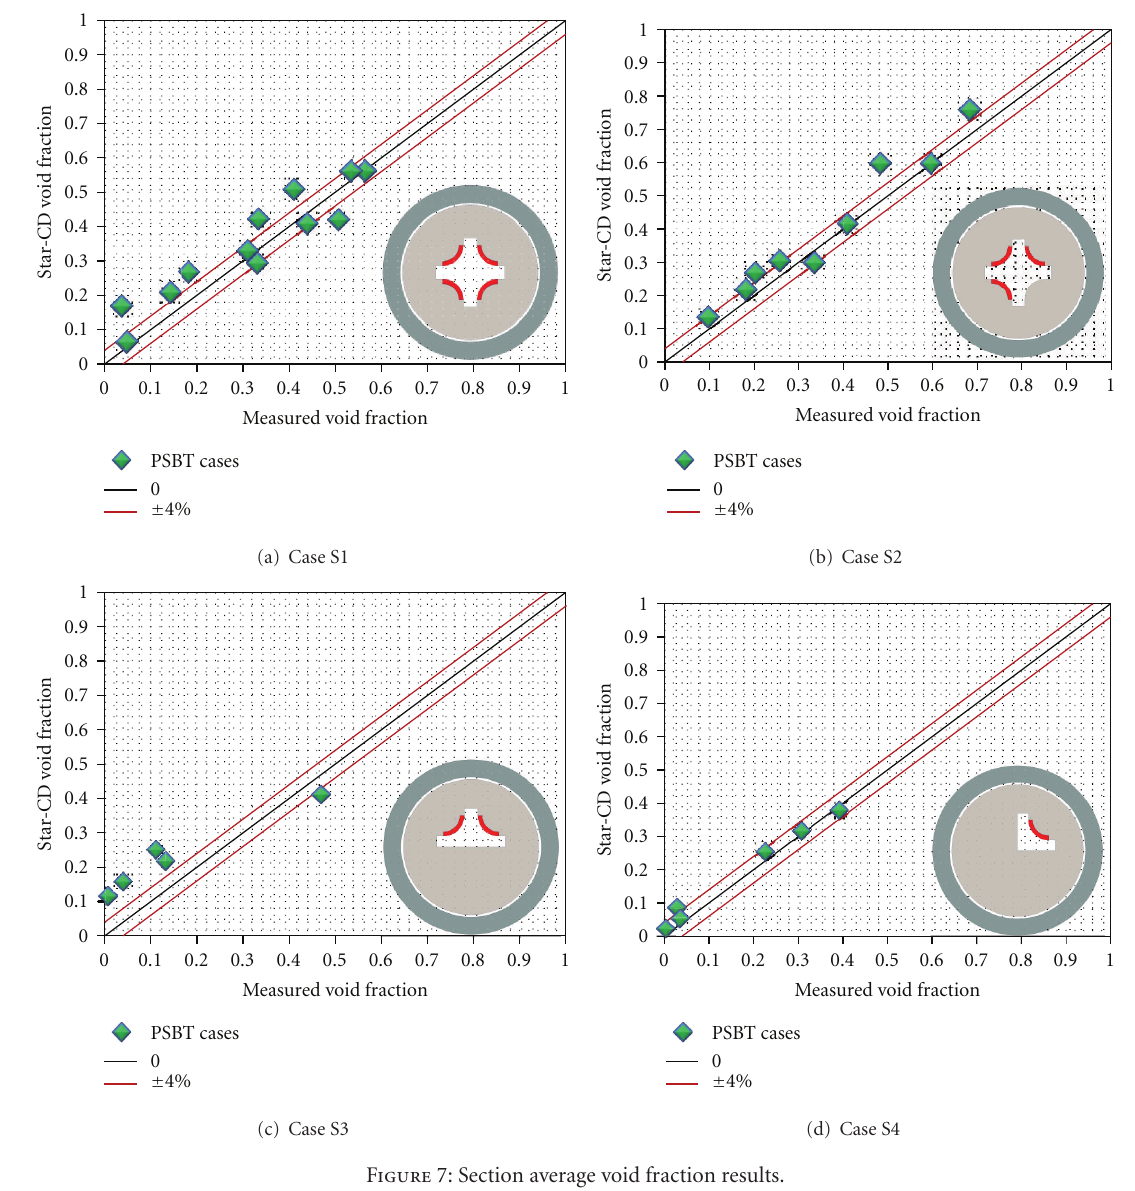
Figure 7: Section average void fraction results.